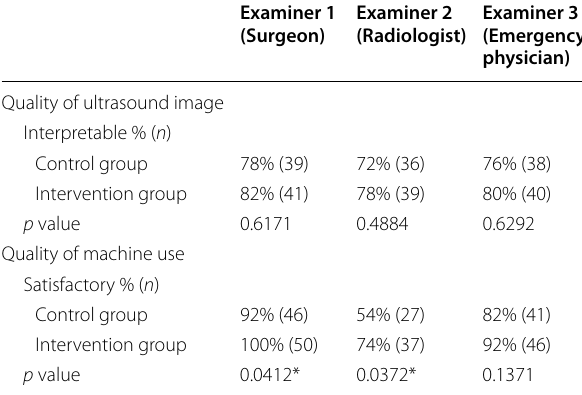
Table 2 Quality of ultrasound image and machine use Table 3 Number of correct diagnoses per group and per patient